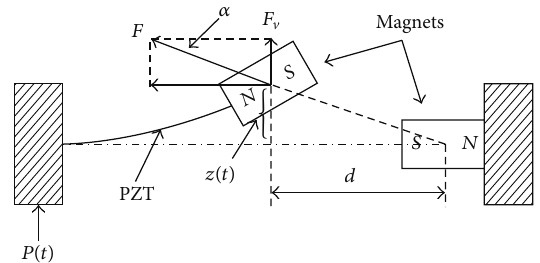
Figure 1: Schematic diagram of nonlinear PVEH system with two